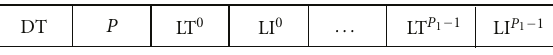
P ... DT Figure 9: LUT information header